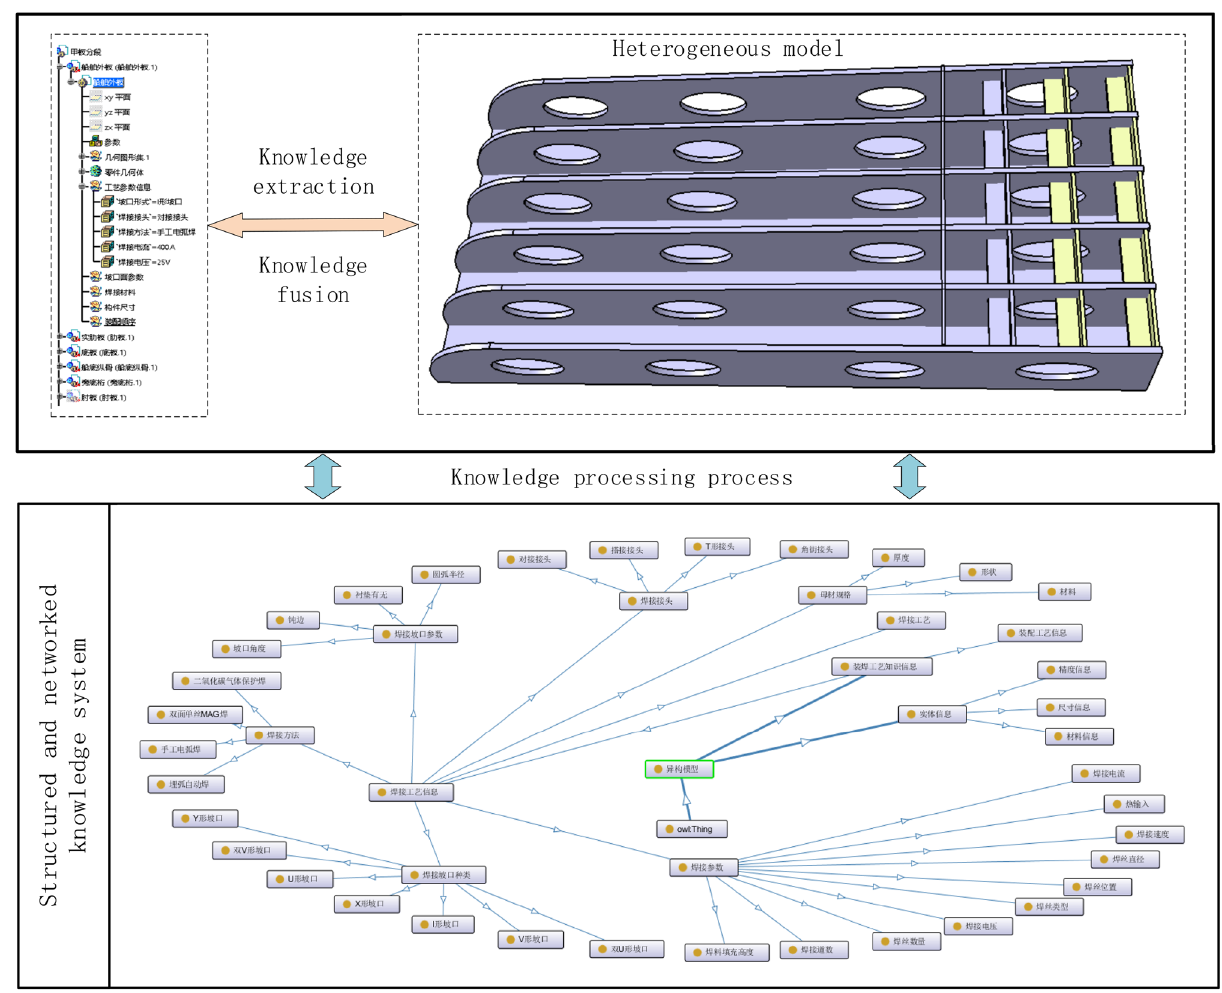
Figure 5. Based on the process knowledge graph to express the process knowledge contained in the heterogeneous